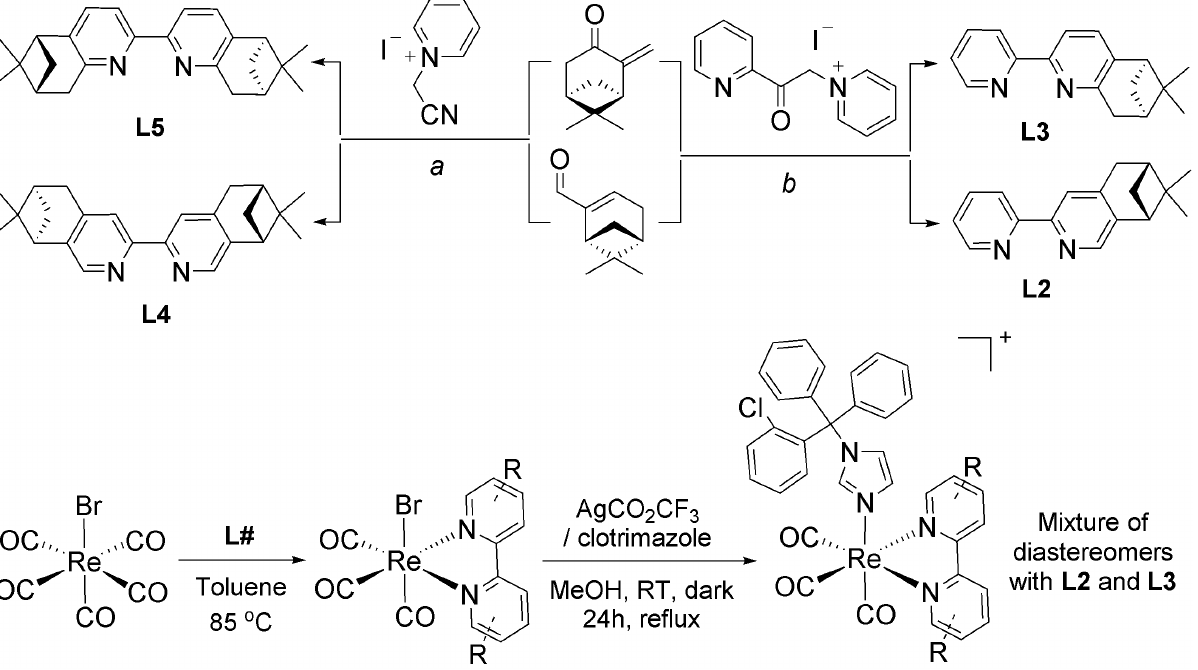
Scheme 1. Top and bottom respectively: general synthetic procedures and chemical